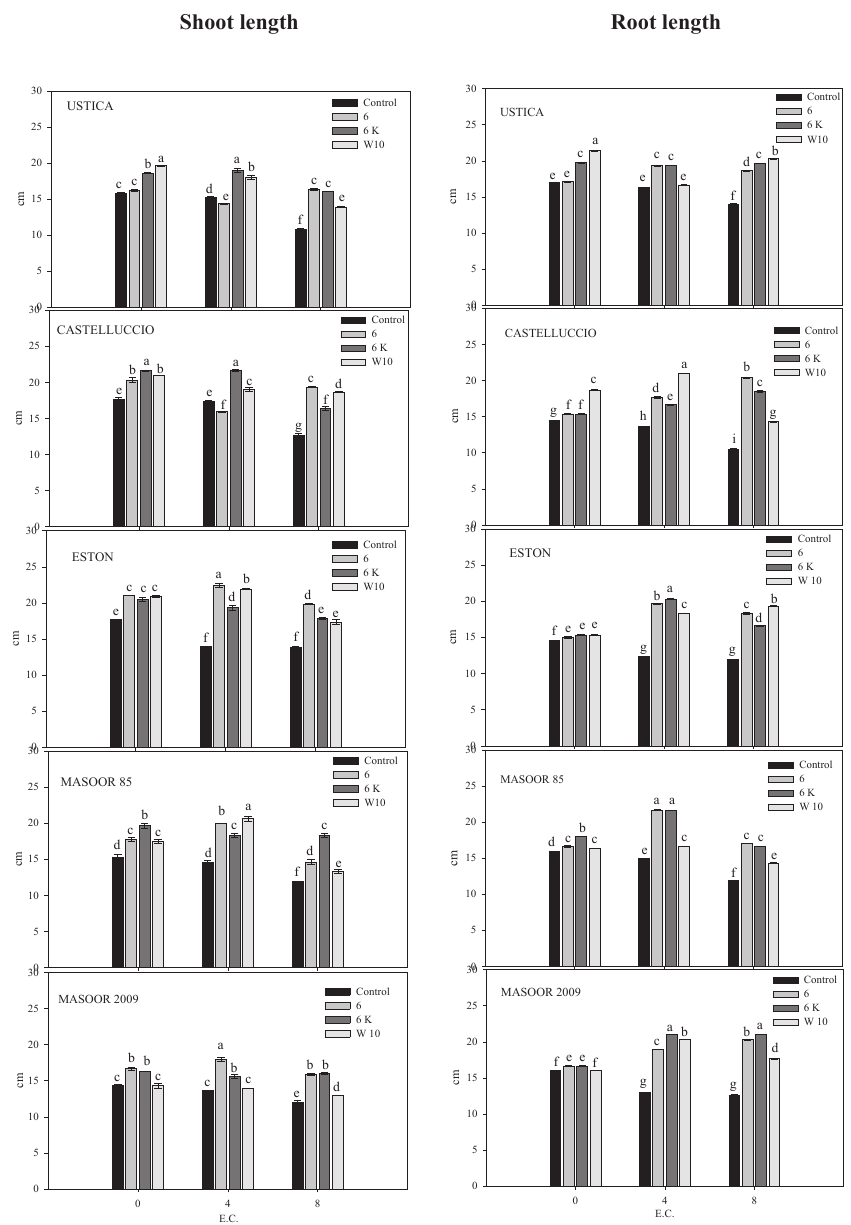
Fig. 1: Shoot and root length (cm) of Ustica (UST), Castelluccio (CAST), Eston (EST), Masoor 85 (MAS) and Punjab (PUN) lentils, 16 days after the inoculation with 6, 6K and W10 strains under different NaCl salinity concentrations (0, 4 and 8 dS m -1 ). Bars represent the mean ± SE. Different letters indicate significant differences (P ≤